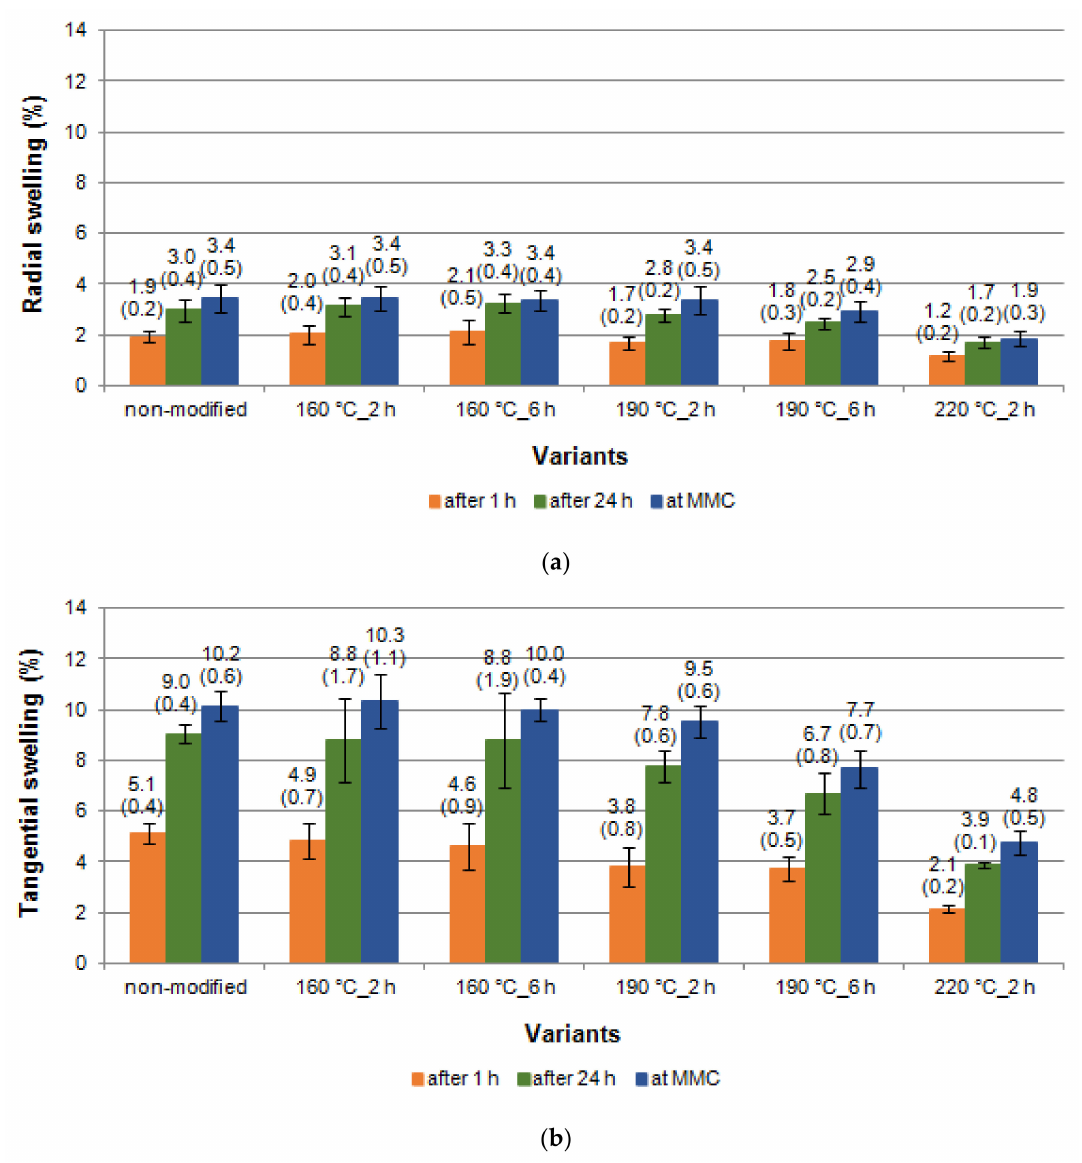
Figure 5. Swelling in the radial ( a ) and tangential ( b ) directions of black poplar thermally modified in nitrogen atmosphere (error bars—-standard deviation ( ±